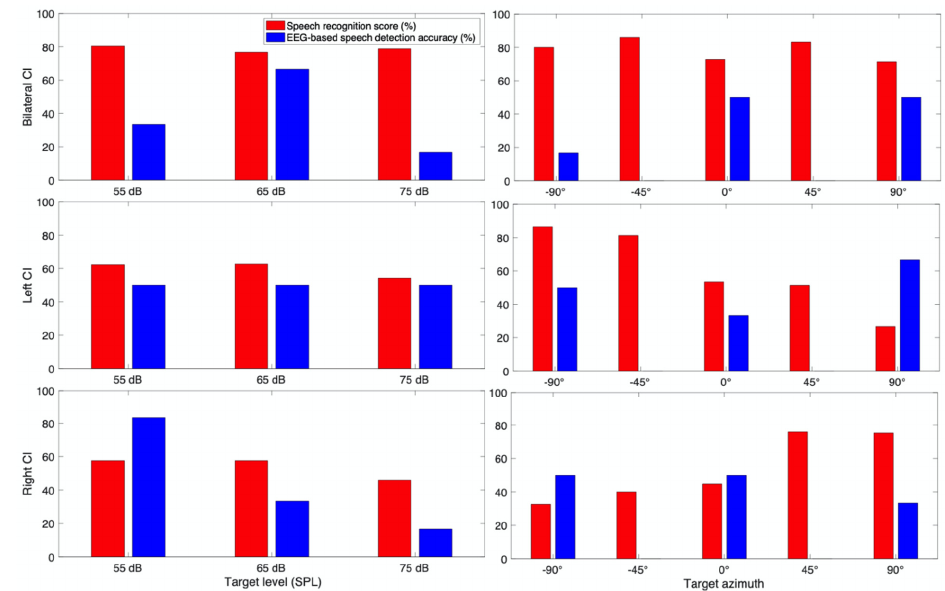
Figure 6. Speech recognition score and speech detection accuracy from EEG for CI